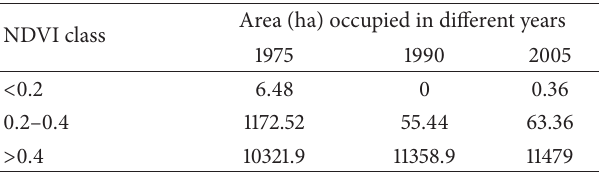
Table 5: Area occupied by different NDVI classes in different years in the 5km buffer area surrounding four villages in